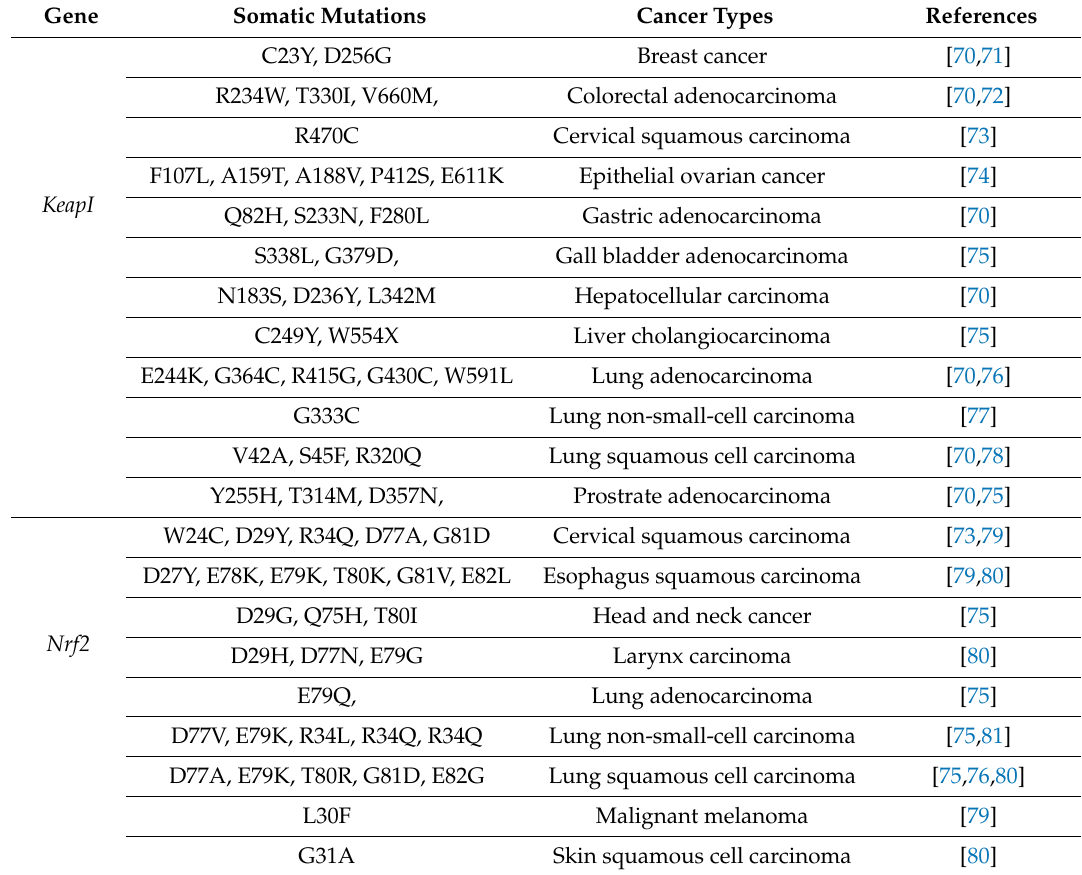
Table 1. Mutations in the Nrf-KeapI system responsible for cancer